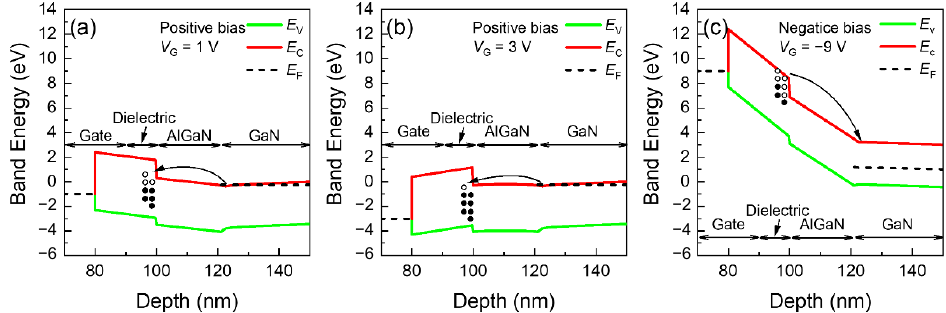
Figure 4. Schematic band diagrams of MIS-HEMTs at ( a ) positive bias (V max = 1 V), ( b ) positive bias (V max = 3 V), and ( c ) negative bias (V gs = −9 V).